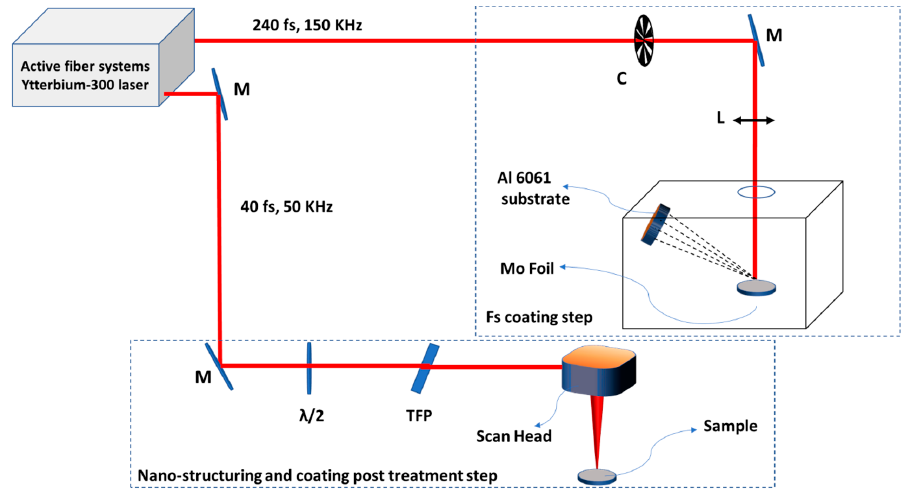
Figure 1. Schematic diagram of the experimental setup: Step 1—femtosecond pulsed laser deposition of the Mo over the substrate (with 240 fs, 150 kHz laser beam), Step 2—post treatment of the sample in step 1 using a scan head (with 40 fs and 50 kHz laser beam), C—optical chopper, M—dielectric mirror, L—objective lens, λ /2—half wave plate, TFP—thin film polarizer. The electrochemical tests were performed using a CH Instruments 660E workstation in 3.5% NaCl solution. A tri-electrode setup with Pt as the wire counter electrode and Ag/AgCl reference electrodes was used. The exposed surface area of the working elec- trode was 1 cm 2 . The open circuit potential (OCP) tests were performed for 2 h on all sam- ples to obtain a stable electrochemical interface. A scan rate of 10 mV and auto sensitivity settings were employed to obtain the Tafel plots (cyclic polarization curves). A negative voltage window of − 1.8 to 0 was employed for the cyclic polarization tests. Electrochemi- cal impedance spectroscopy (EIS) analyses were performed at OCP in a frequency range of 100 Hz–1 M Hz and 10 mV excitation amplitude. Table 1. Laser parameters for nano-structuring and coating. Laser Parameter Value